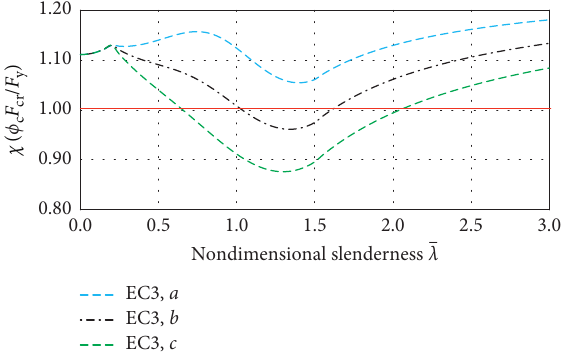
Figure 3: Capacity reduction ratios ( χ /( ϕ buckling curves a , b , and c